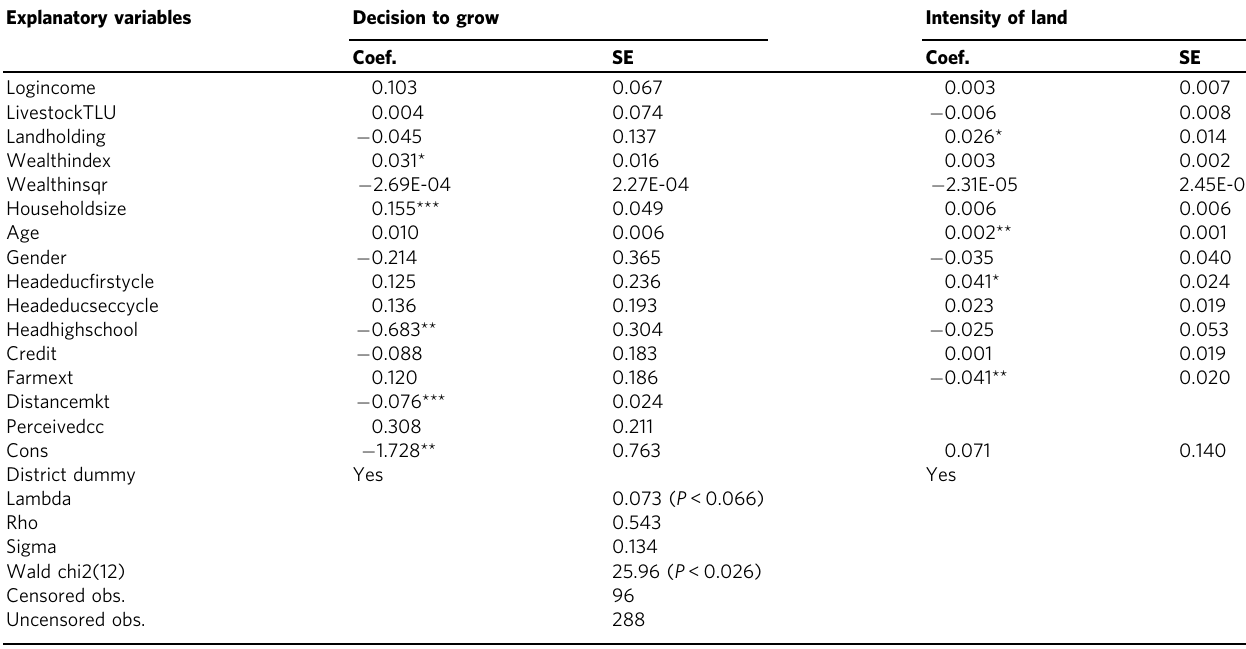
Table 7 Model result of land use for grass pea production by households (note: dependent variable is the size of land in ha). Explanatory variables Decision to